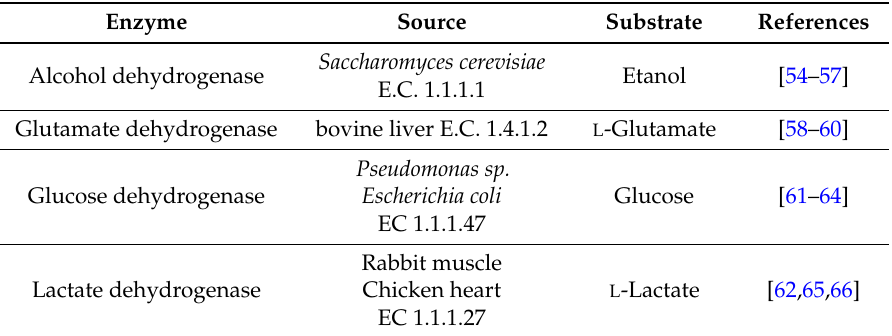
Table 2. Examples of dehydrogenase enzymes used in amperometric biosensors. Enzyme Source